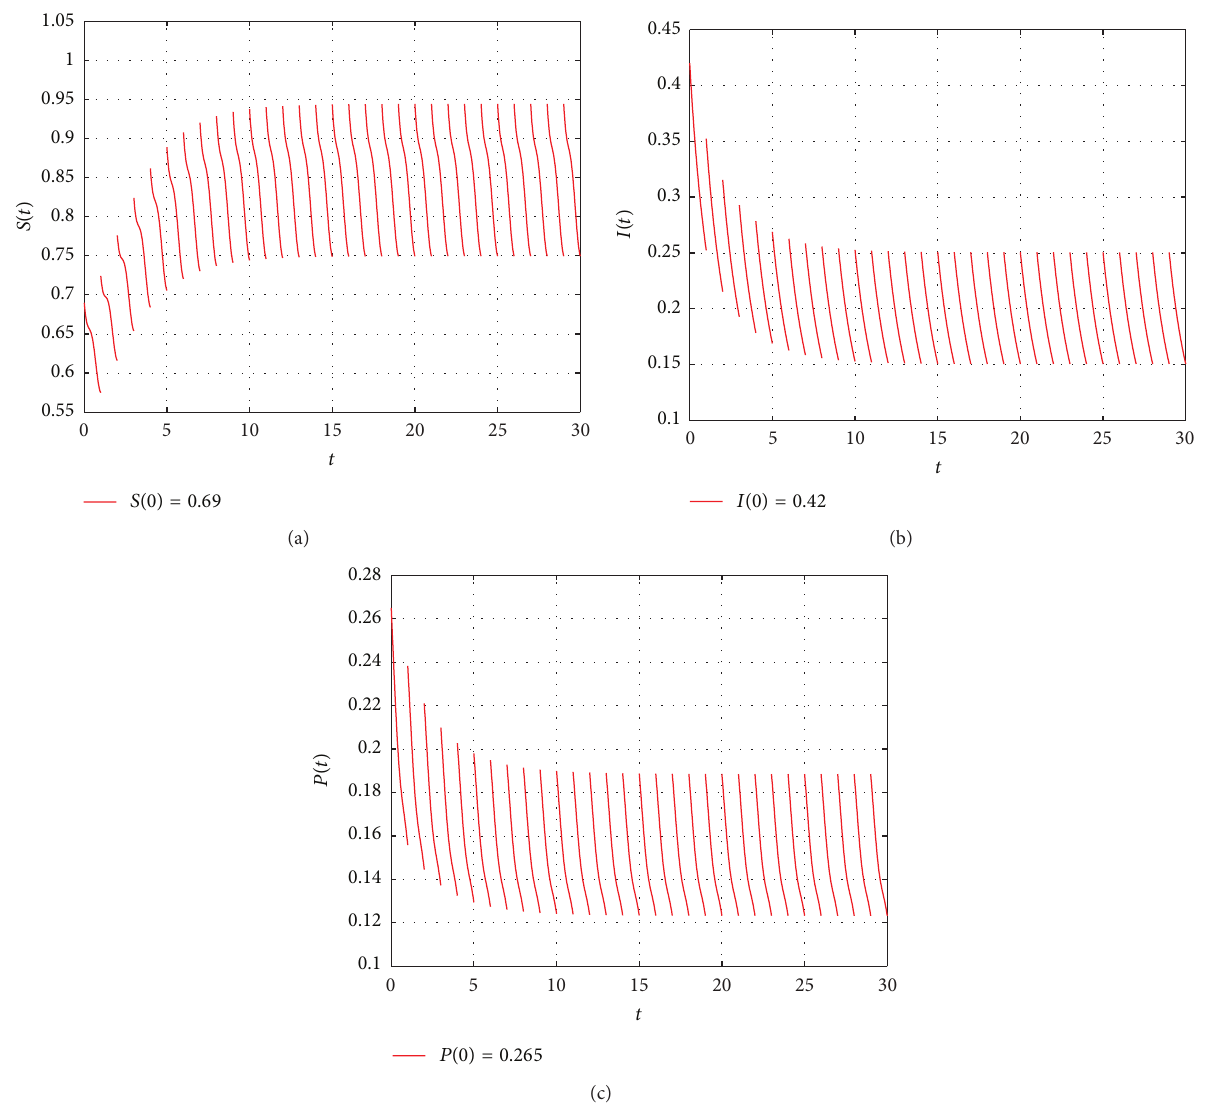
Figure 2: Permanence of system (80) with 𝛼 𝑘 = 0.26 , 𝑝 = 0.1 , and 𝛾 𝑘 = 0.53 . (a) Time series of 𝑆 for 𝑡 ∈ [0, 30] . (b) Time series of 𝐼 for 𝑡 ∈ [0, 30] . (c) Time series of 𝑃 for 𝑡 ∈ [0, 30]